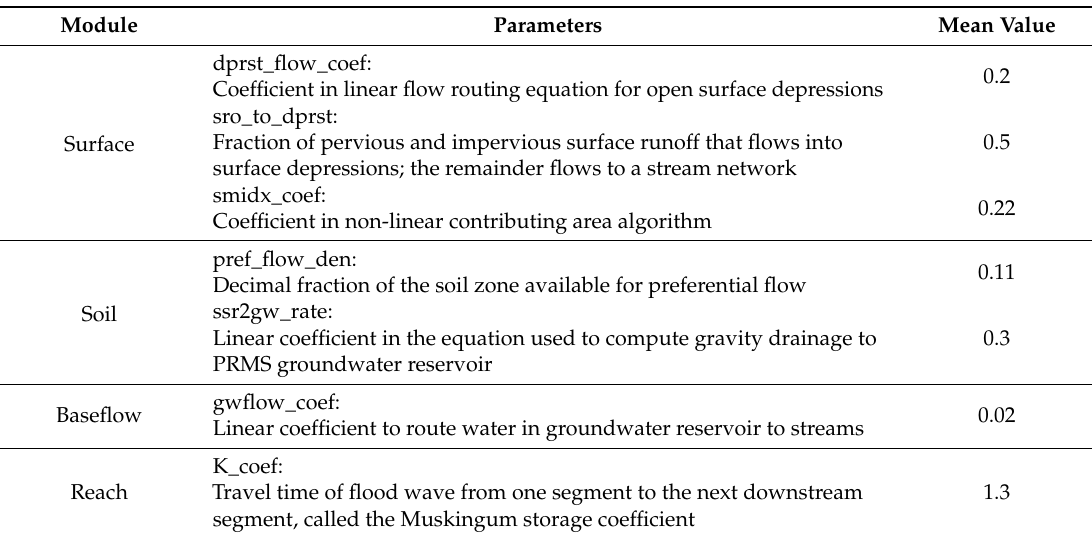
Table 1. Major calibrated parameters’ value of